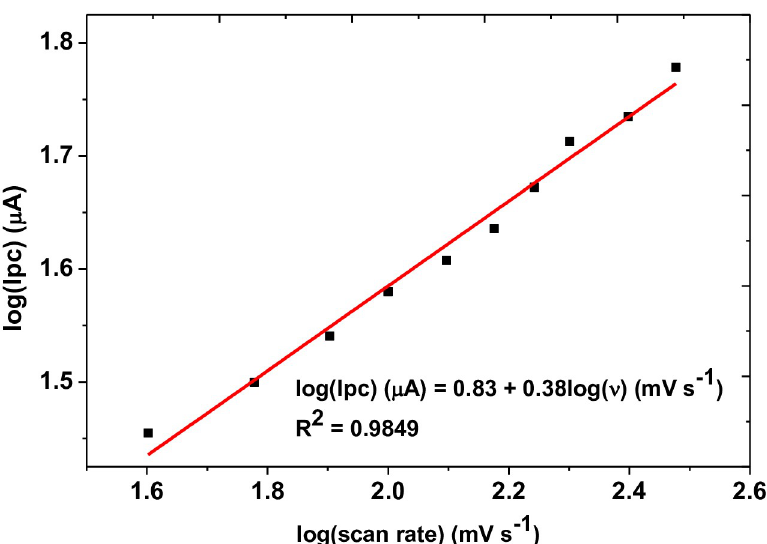
Fig 8. Plot of log(Ip) versus log( v ) in a scan rate range of 40–300 mV s -1